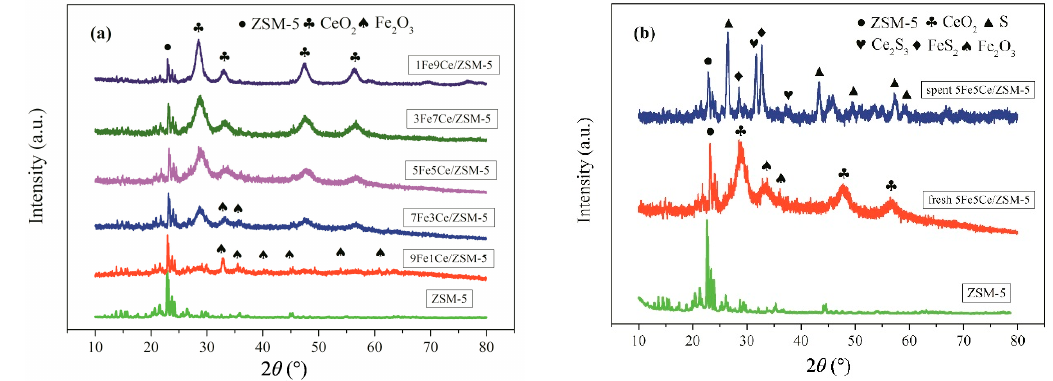
Figure 3. X-ray diffraction (XRD) patterns: ( a ) ZSM-5 and fresh x Fe y Ce/ZSM-5; ( b ) fresh and spent 5Fe5Ce/ZSM-5.